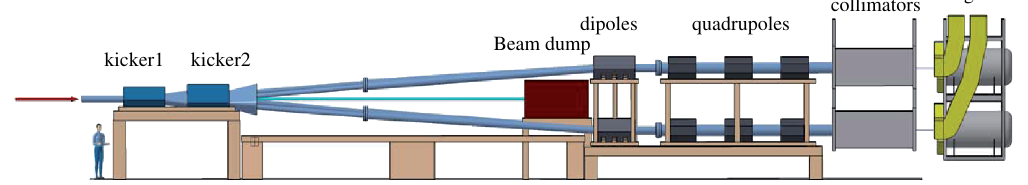
FIG. 5. Side view of the distribution